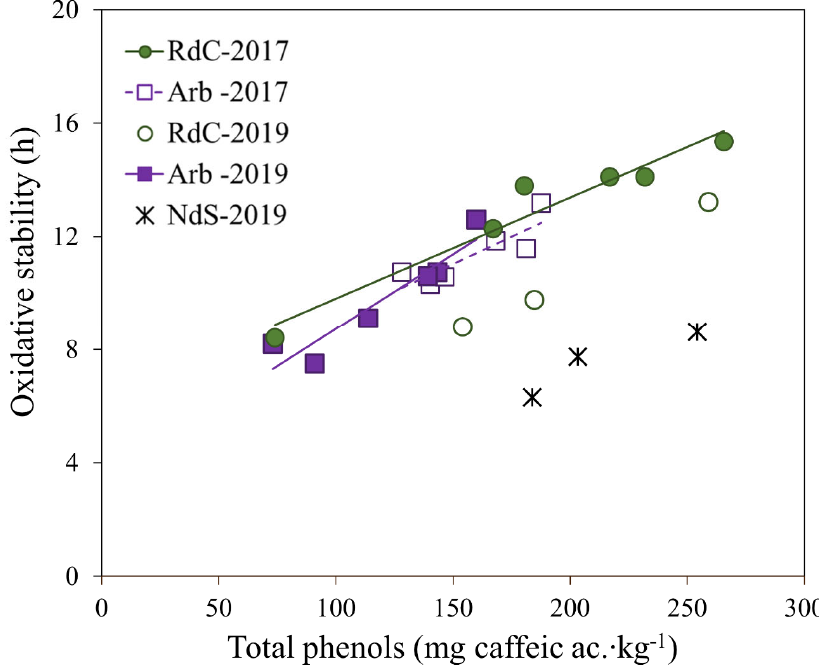
Figure 5. Linear regression of oxidative stability vs. total polyphenol content for “Arbequina” (Arb; square; violet), “Royal de Calatayud” (RdC; circle; green), and “Negral de Sabiñán” (NdS; cross; black) olive oil samples obtained in 2017 (solid marker) and 2019 (unfilled marker) crop years.